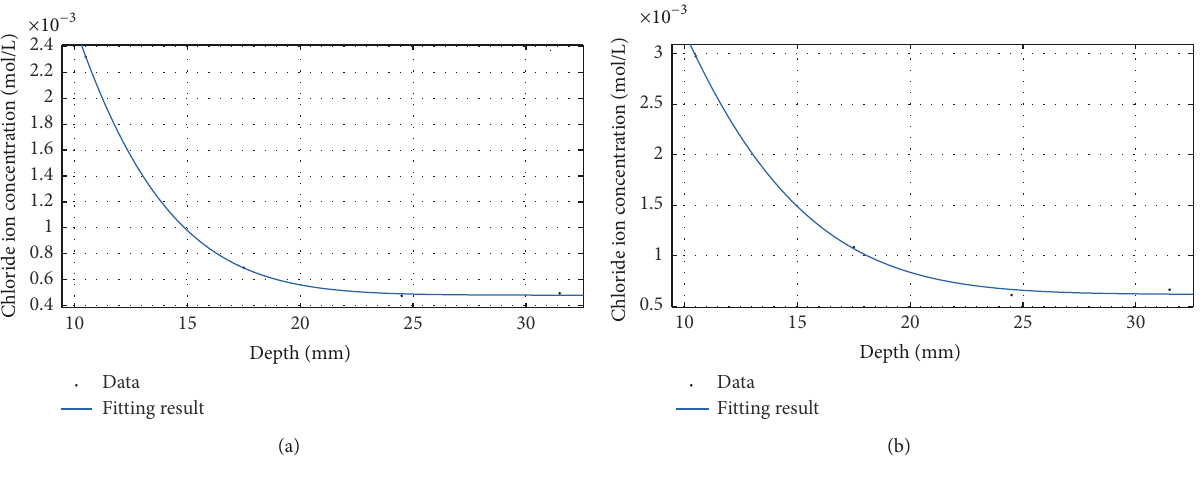
Figure 9: Curve fitting of chloride ion concentration.